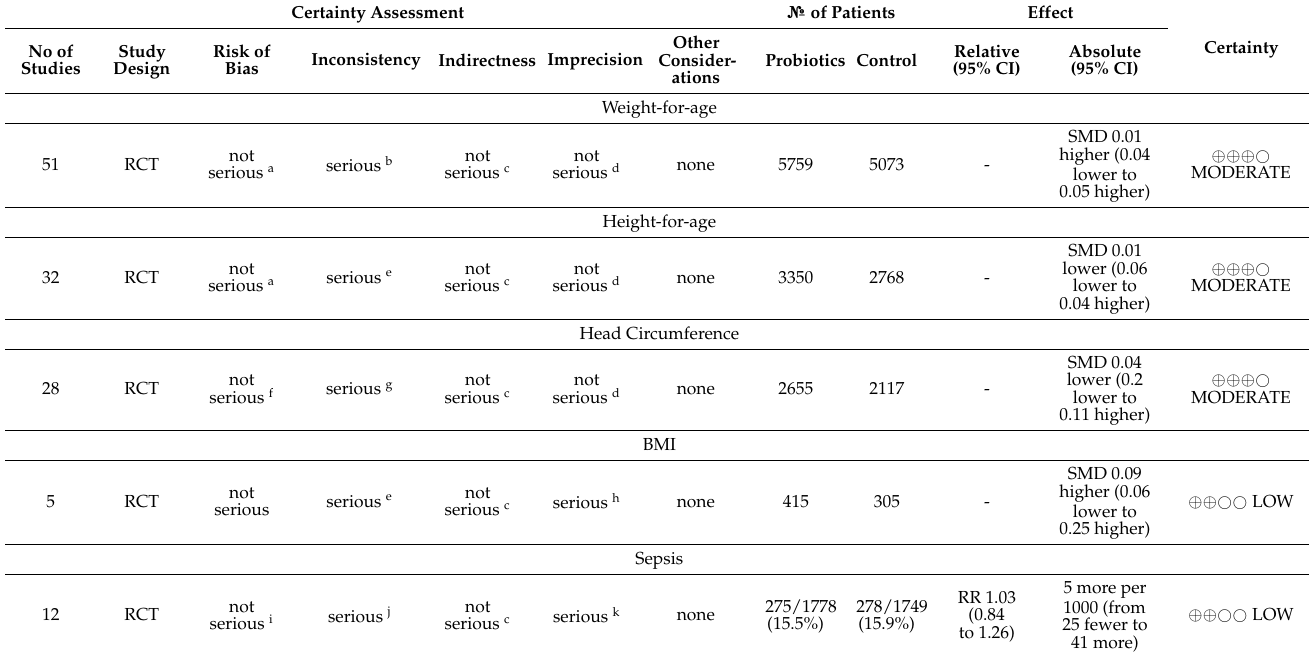
Table 2. Summary-of-Findings table showing results of GRADE analysis of overall evidence for effect of probiotics in children 0–59 months of age in high-income